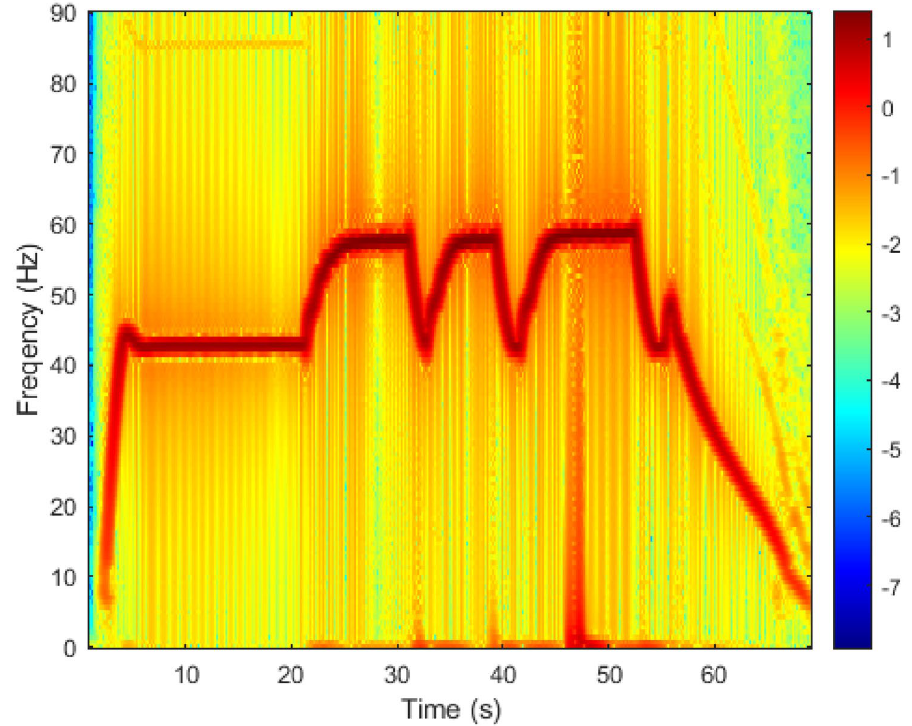
Fig. 8 SFT results of the pres- sure in idle